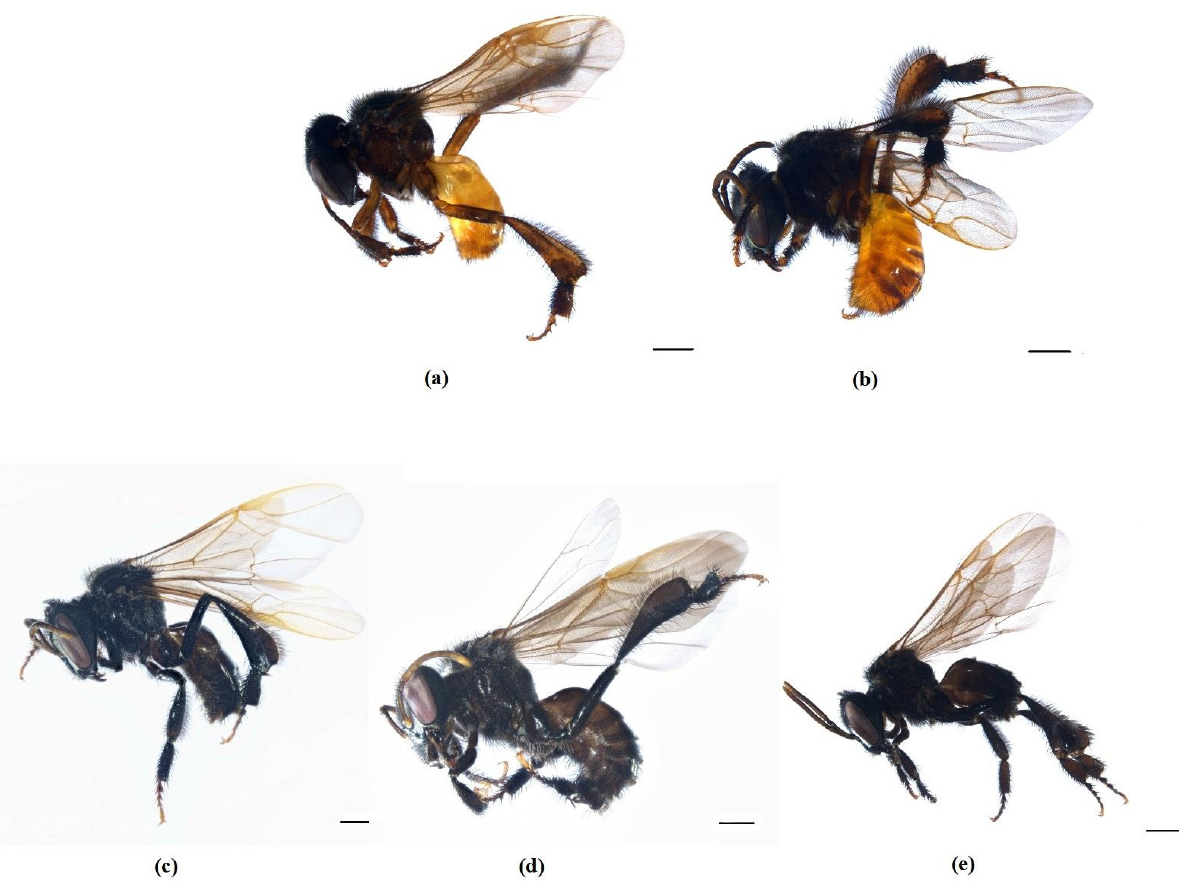
Figure 3. Specimens of Trigona spp. ( a ) T. cf. fulviventris Clade A (MA10), ( b ) T. cf. fulviventris Clade B (MA6), ( c ) T. guianae (UT11), ( d ) T. cf. guianae Clade A (POA9), ( e ) T. cf. guianae Clade B (PY12). Scale bar: 1 mm.